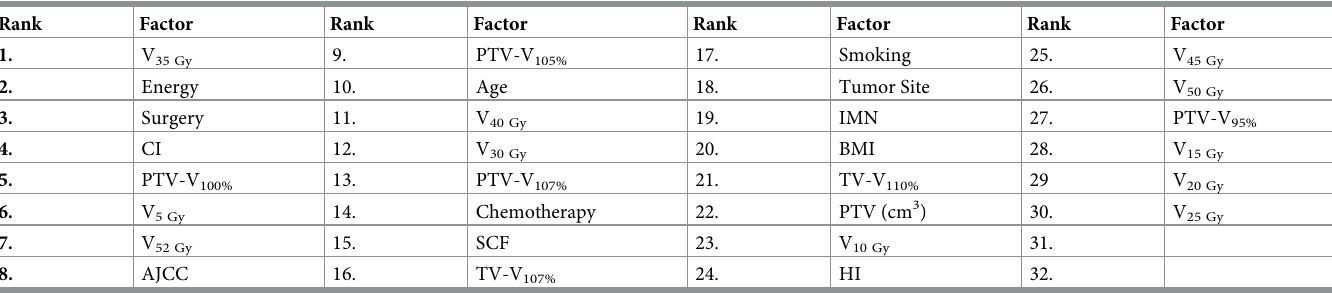
Table 3. Predictive factors correlation ranked by